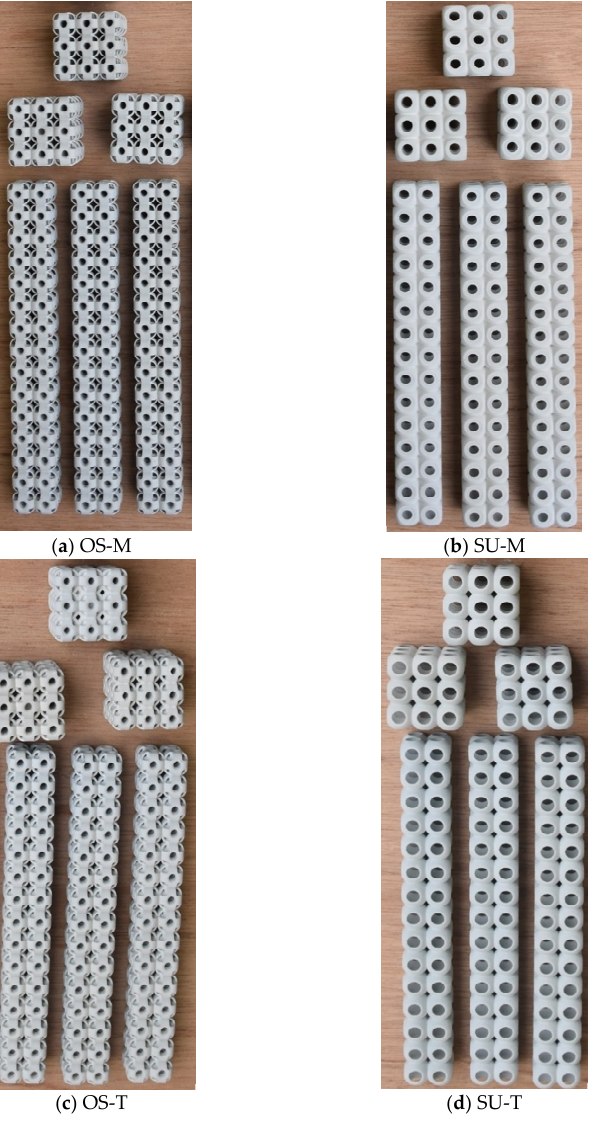
Figure 3. Three specimens of each sample were printed by additive manufacturing (Multi Jet Fusion 3D Printer). ( a ) OS structure with constant mass; ( b ) SU structure with constant mass; ( c ) OS structure with constant wall thickness; ( d ) SU structure with constant wall thickness.